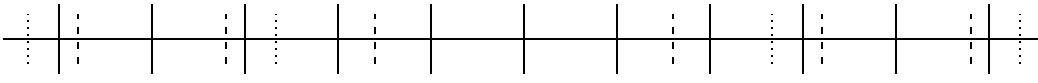
Figure 2 . Distribution of states in the intervals (E.5) for the case of k + = 5, k (cid:0) = 3. Solid markers indicate the boundary of an interval, dotted markers are multiples of 1 are multiples of 1 k (cid:0) . One can clearly see that there is precisely one point where all markers meet 2 and the following solid interval does not contain any other marker. Apart from this exception, every two solid markers enclose exactly one dotted or dashed marker. Hence either no marker meets or all three markers meet at one